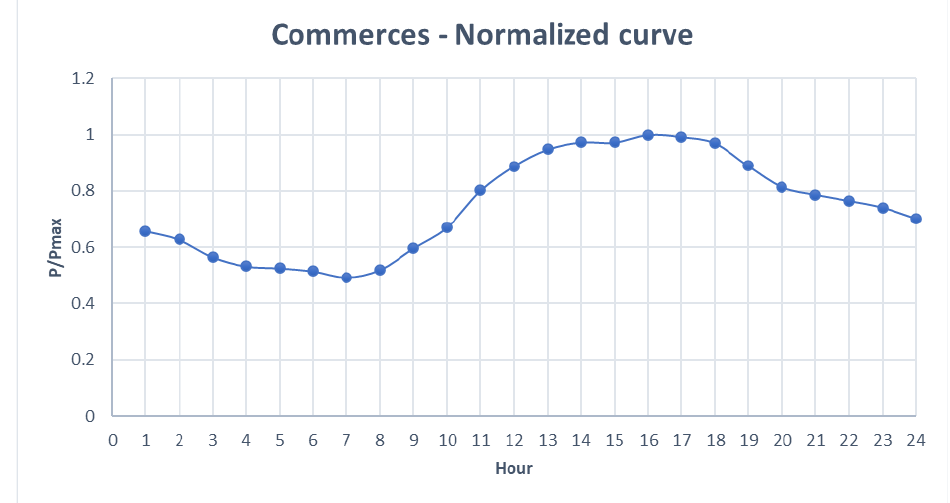
Figure A4. Annual load curve on daily basis used for the tertiary sector (based on Hayes [46]).